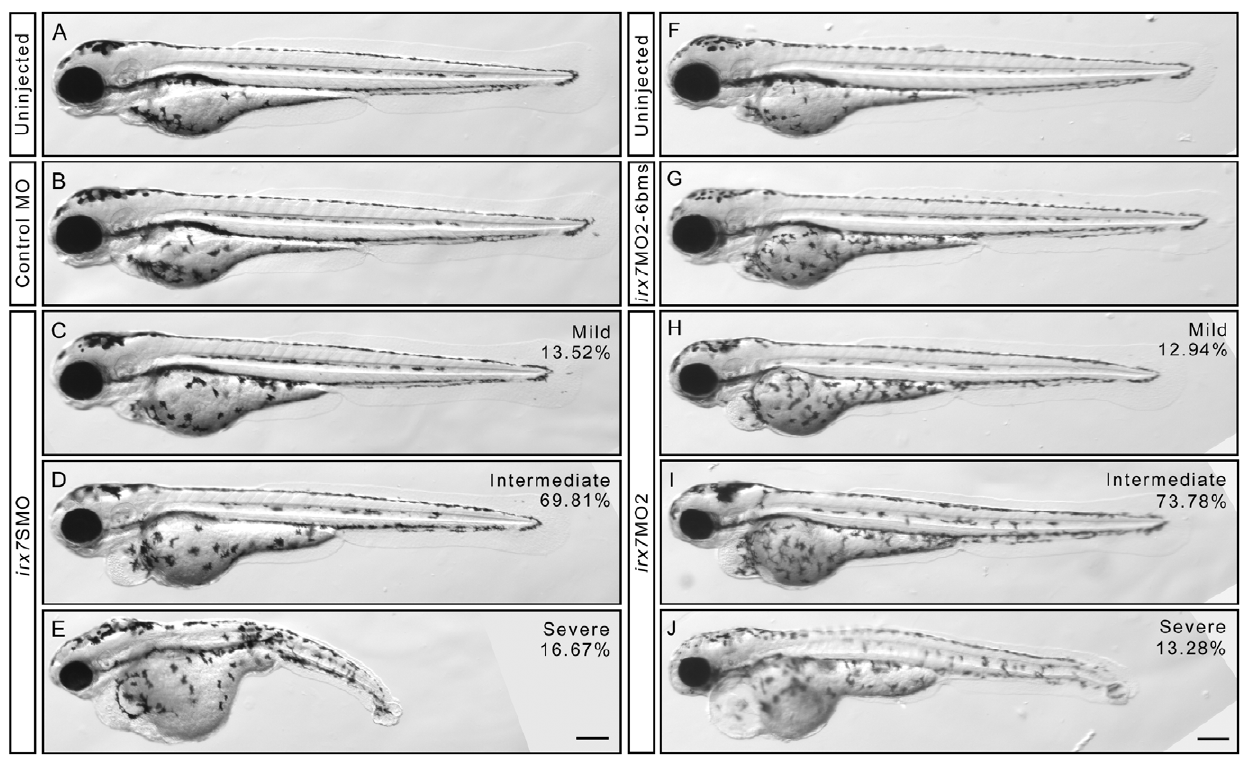
Figure 3. The phenotypes of irx7 SMO and irx7 MO2 morphants at 72 hpf. Phenotypic analysis of the optimized irx7 SMO (A–E) and irx7 MO2 (F–J) injection experiments. (A) The lateral view of an uninjected control embryo for irx7 SMO injection experiments. (B) An embryo injected with 10 ng of Control MO. (C–E) Three phenotypic categories of the morphants after injected with 10 ng of irx7 SMO. The percentage of embryos that had mild (C), intermediate (D) and severe (E) phenotypes was 13.52% (N=106), 69.81% (N=444) and 16.67% (N=86) respectively. (F) The lateral view of an uninjected control embryo for irx7 MO2 injection experiments. (G) An embryo injected with 3 ng of irx7 MO2-6 bms. (H–J) Three phenotypic categories of morphants after injected with 3 ng of irx7 MO2. The percentage of embryos that had mild (H), intermediate (I), and severe (J) phenotypes were 13.28% (N=38), 73.78% (N=211) and 12.94% (N=37) respectively. Scale bar=200 m m.